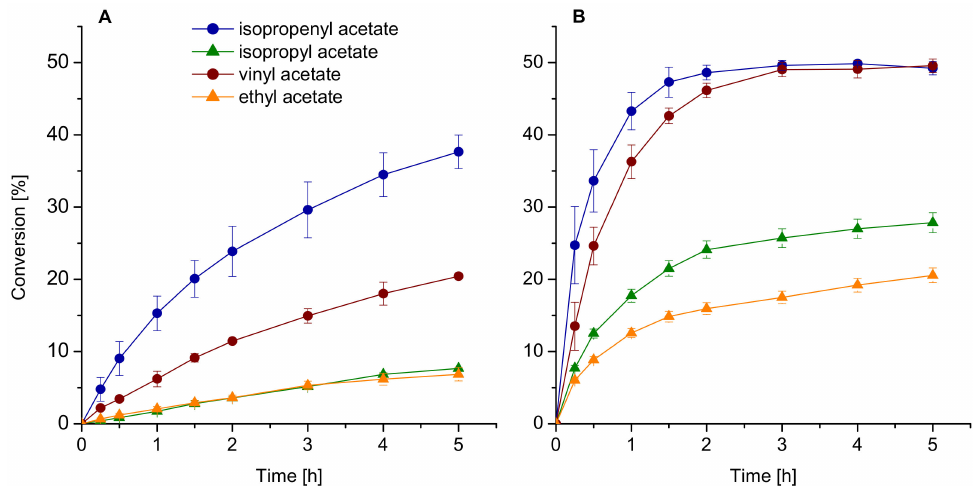
Figure 2. Effect of the acyl donor on the performance of CALB-MCF-3.0Me catalyst ( A ) and Novozym 435 ( B ) in the transesterification of ( rac )-1-phenylethanol.